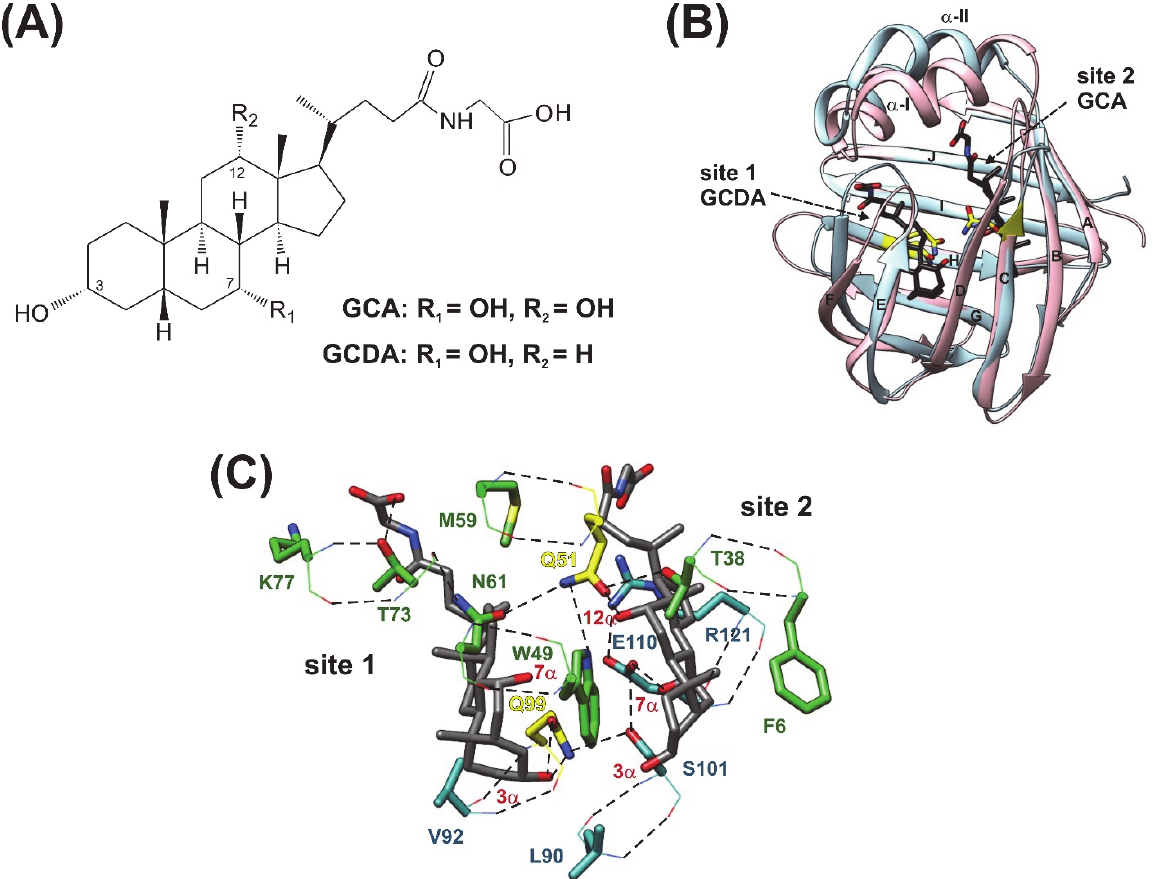
Figure 1. ( A ) Chemical structure of glycocholic acid (GCA) and glycochenodeoxycholic acid (GCDA), the two most abundant bile salts in humans. ( B ) Superimposed ribbon diagrams of apo human I-BABP (PDB: 1O1U, blue) [15] and the heterotypic doubly-ligated human I-BABP:GCDA:GCA complex (PDB: 2MM3, pink) [19]. Mutated residues investigated in this work are indicated in yellow. Bound bile salts are shown in black. The most representative member of the lowest energy structural ensemble is shown for both the apo and the holo forms. ( C ) Stabilizing H-bond interactions in the binding pocket of the heterotypic doubly-ligated hI-BABP complex. Residues involving H-bond networks including Q51 and Q99 are shown in green and cyan, respectively. H-bonds are depicted in black. The two mutated residues are indicated in yellow. Backbone and side chain atoms are depicted in lines and stick,